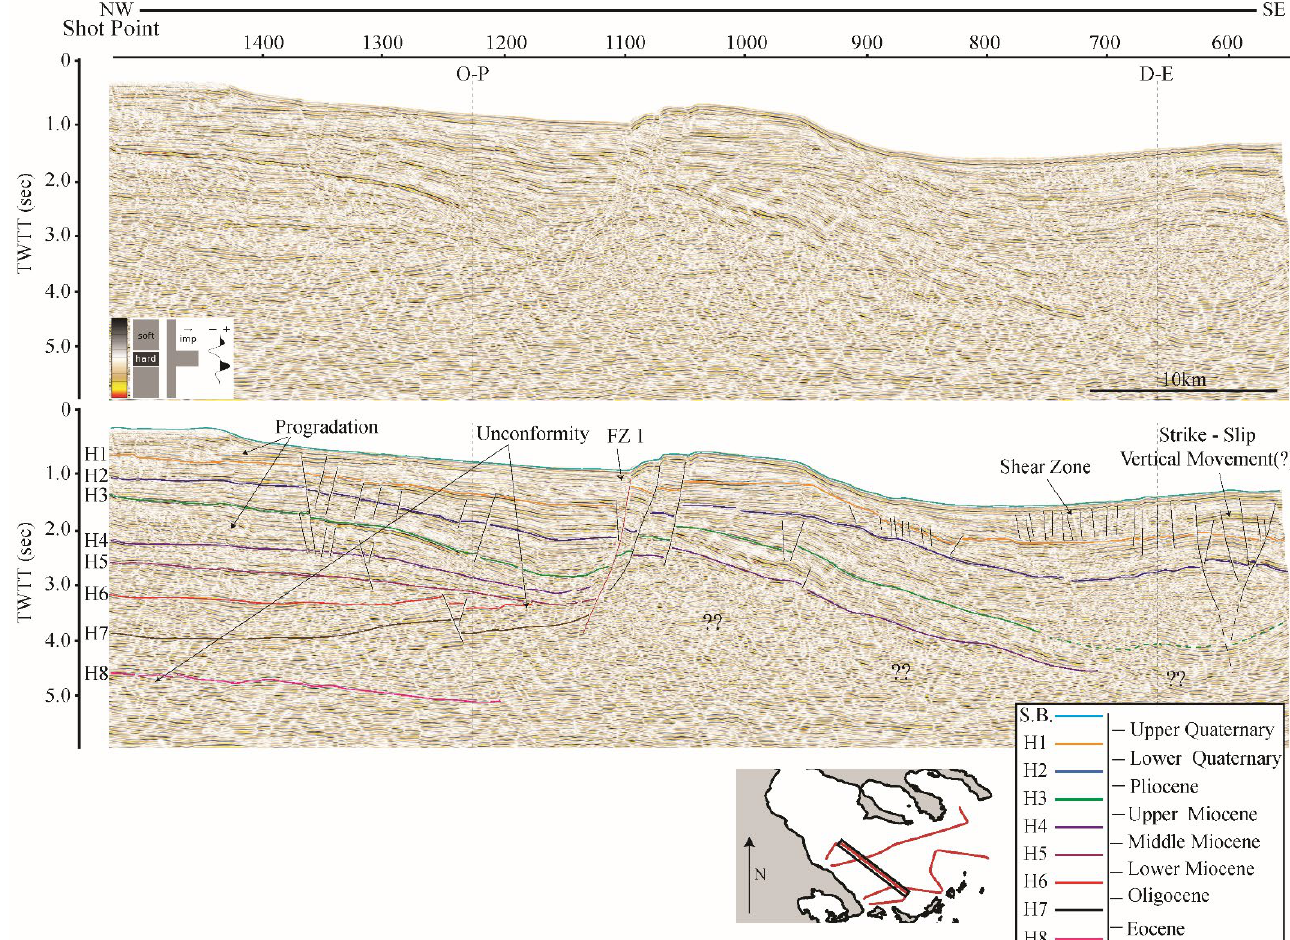
Figure 5. Seismic Line ΝΟ . Left part: un-interpreted regional seismic profile. Right part: interpreted seismic section with highlighted key horizons and the most prominent tectonic elements.